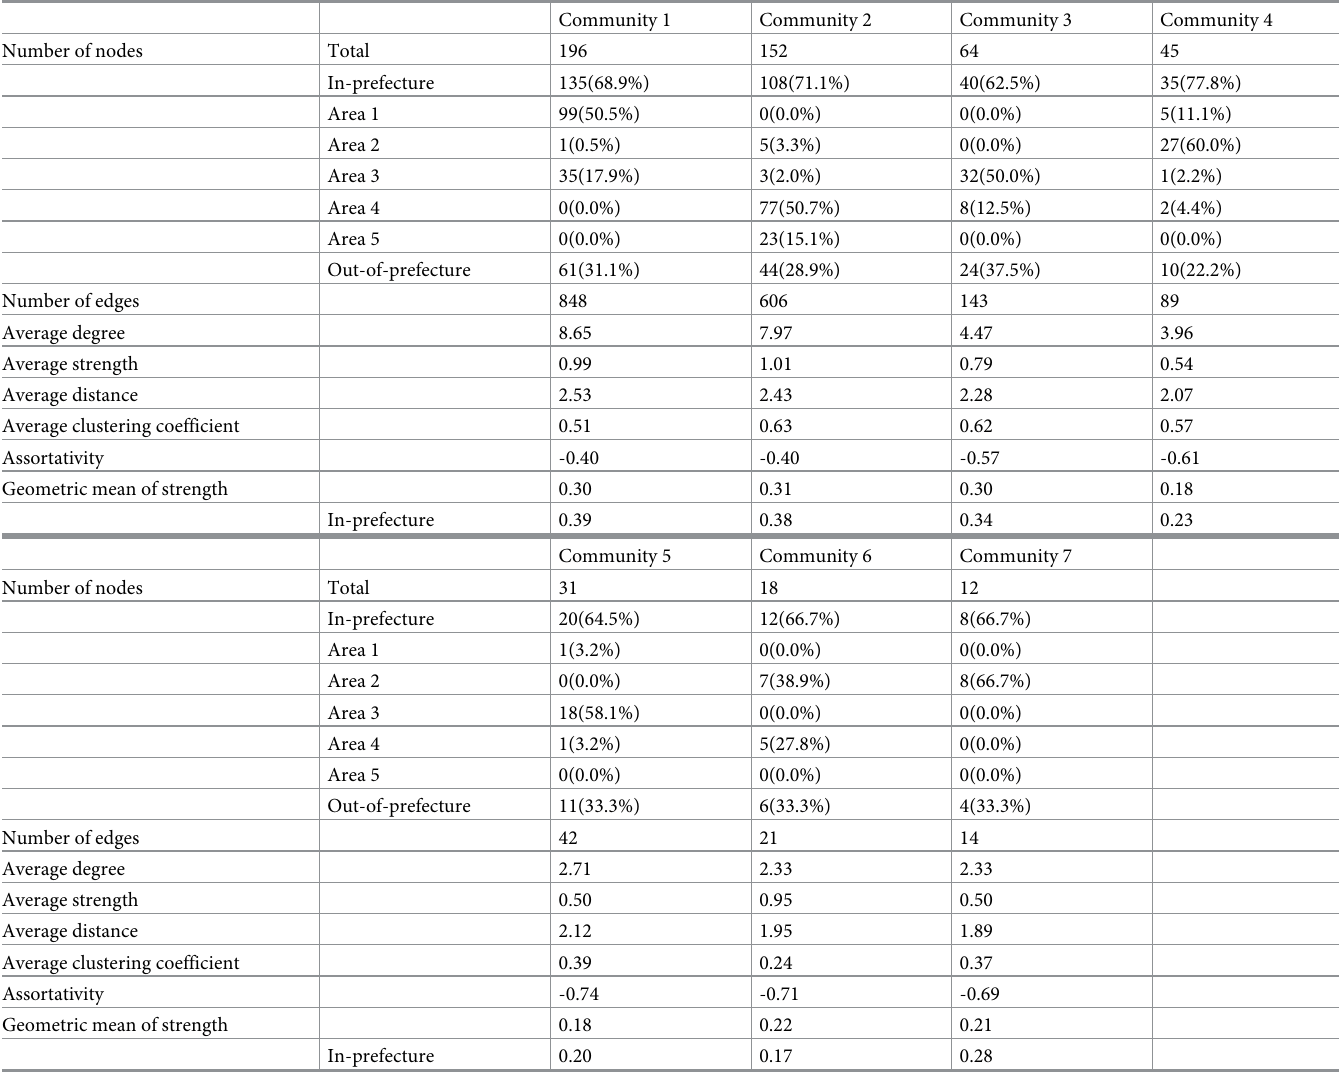
Table 6. Network features of